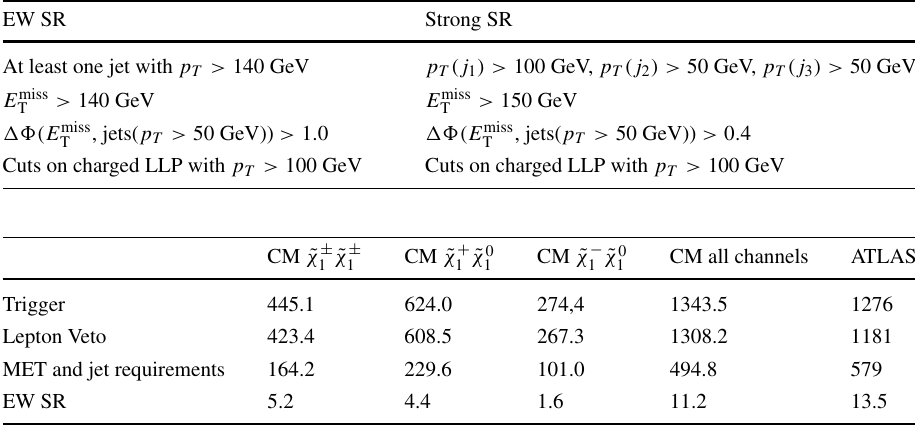
EW SR Strong SR